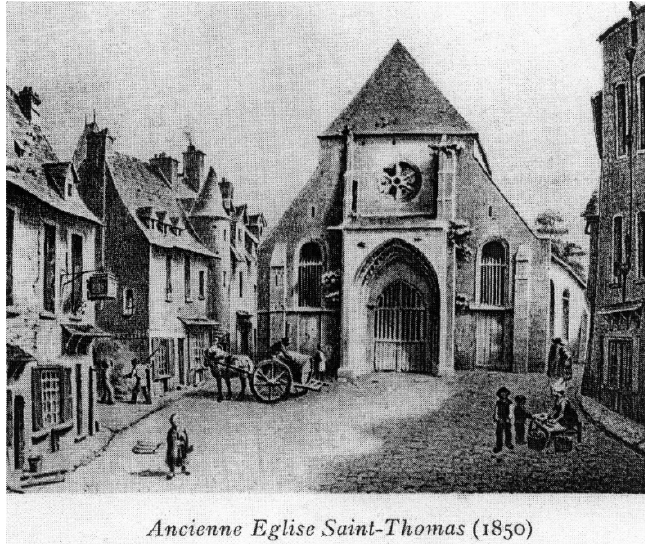
Figure 3. Saint-Lô, Saint-Thomas Church, deconsecrated 1811, demolished 1895. © Toustain de Billy 1912, opposite p. 224 (image in the public domain).